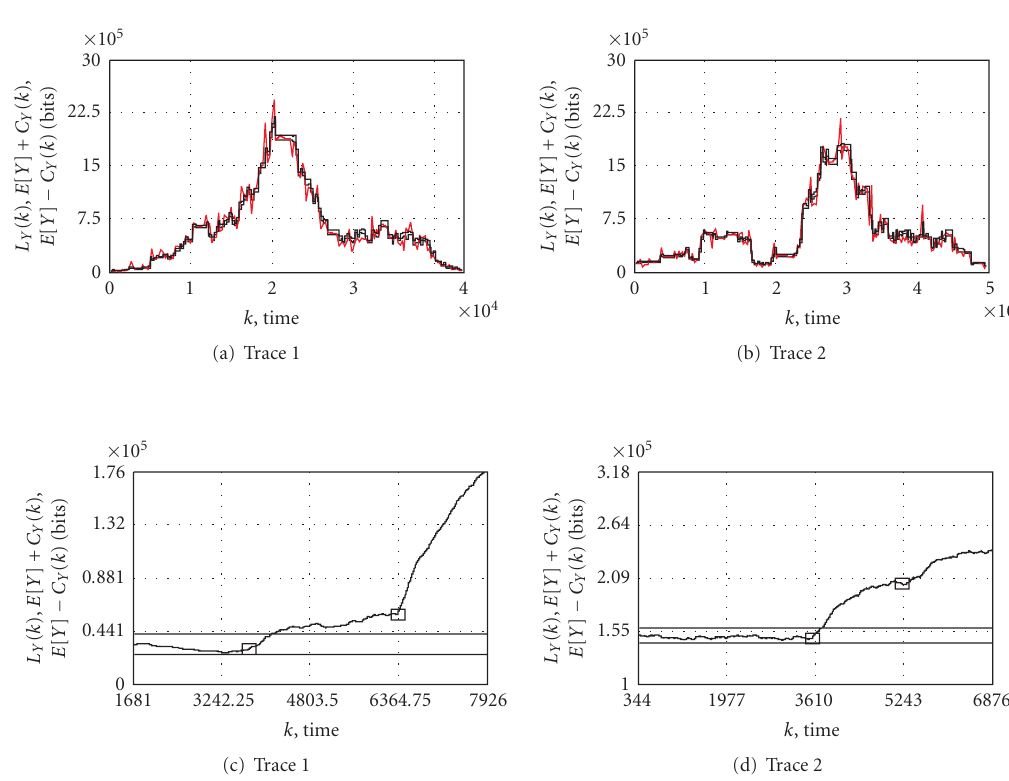
Figure 12: EWMA statistics: varying number of sources ( γ = 0 .